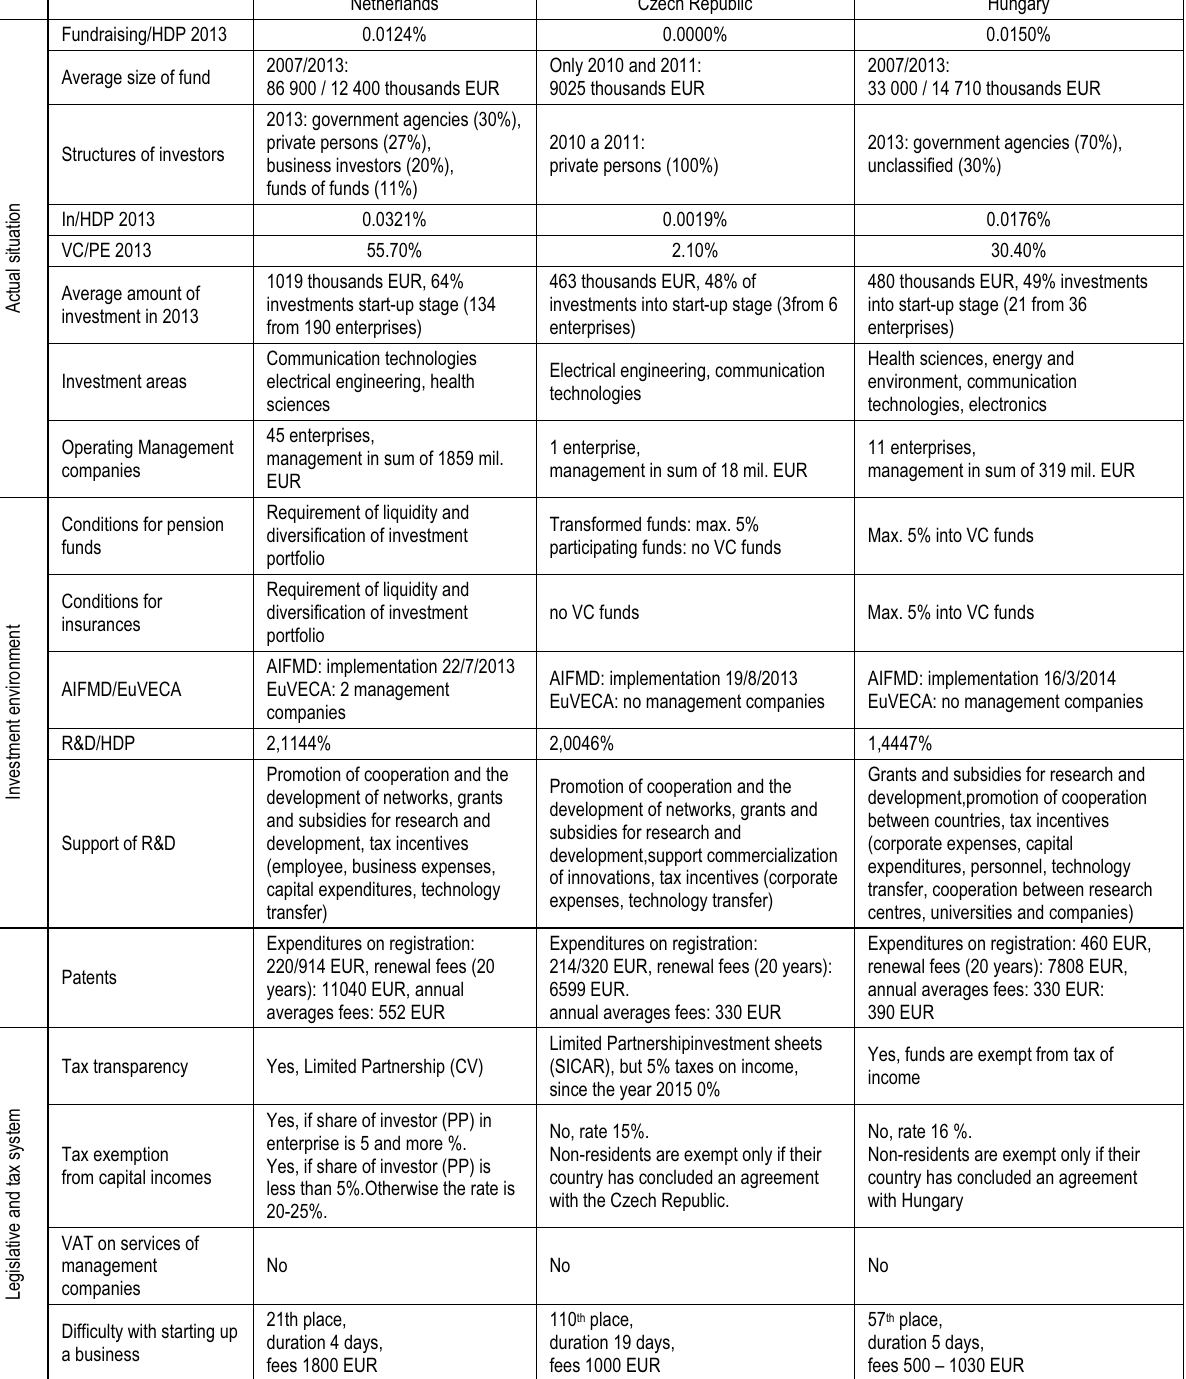
Table 3. Results of comparative study: the Czech Republic, the Netherlands and